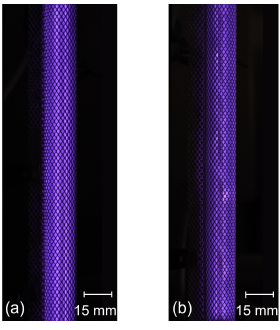
Figure 5. Discharge images taken by a digital camera with an exposure time of 10 s. ( a ) Swirling- flow-type reactor without the Coand˘a effect. ( b ) Swirling-flow-type reactor with the Coand˘a effect (number of nylon wire turns: 10). The streamer discharges were generated by the nanosecond-pulsed voltage, whose peak value and repetition frequency were 27 kV and 100 pps, respectively, while the solution was circulated with a flow rate of 1400